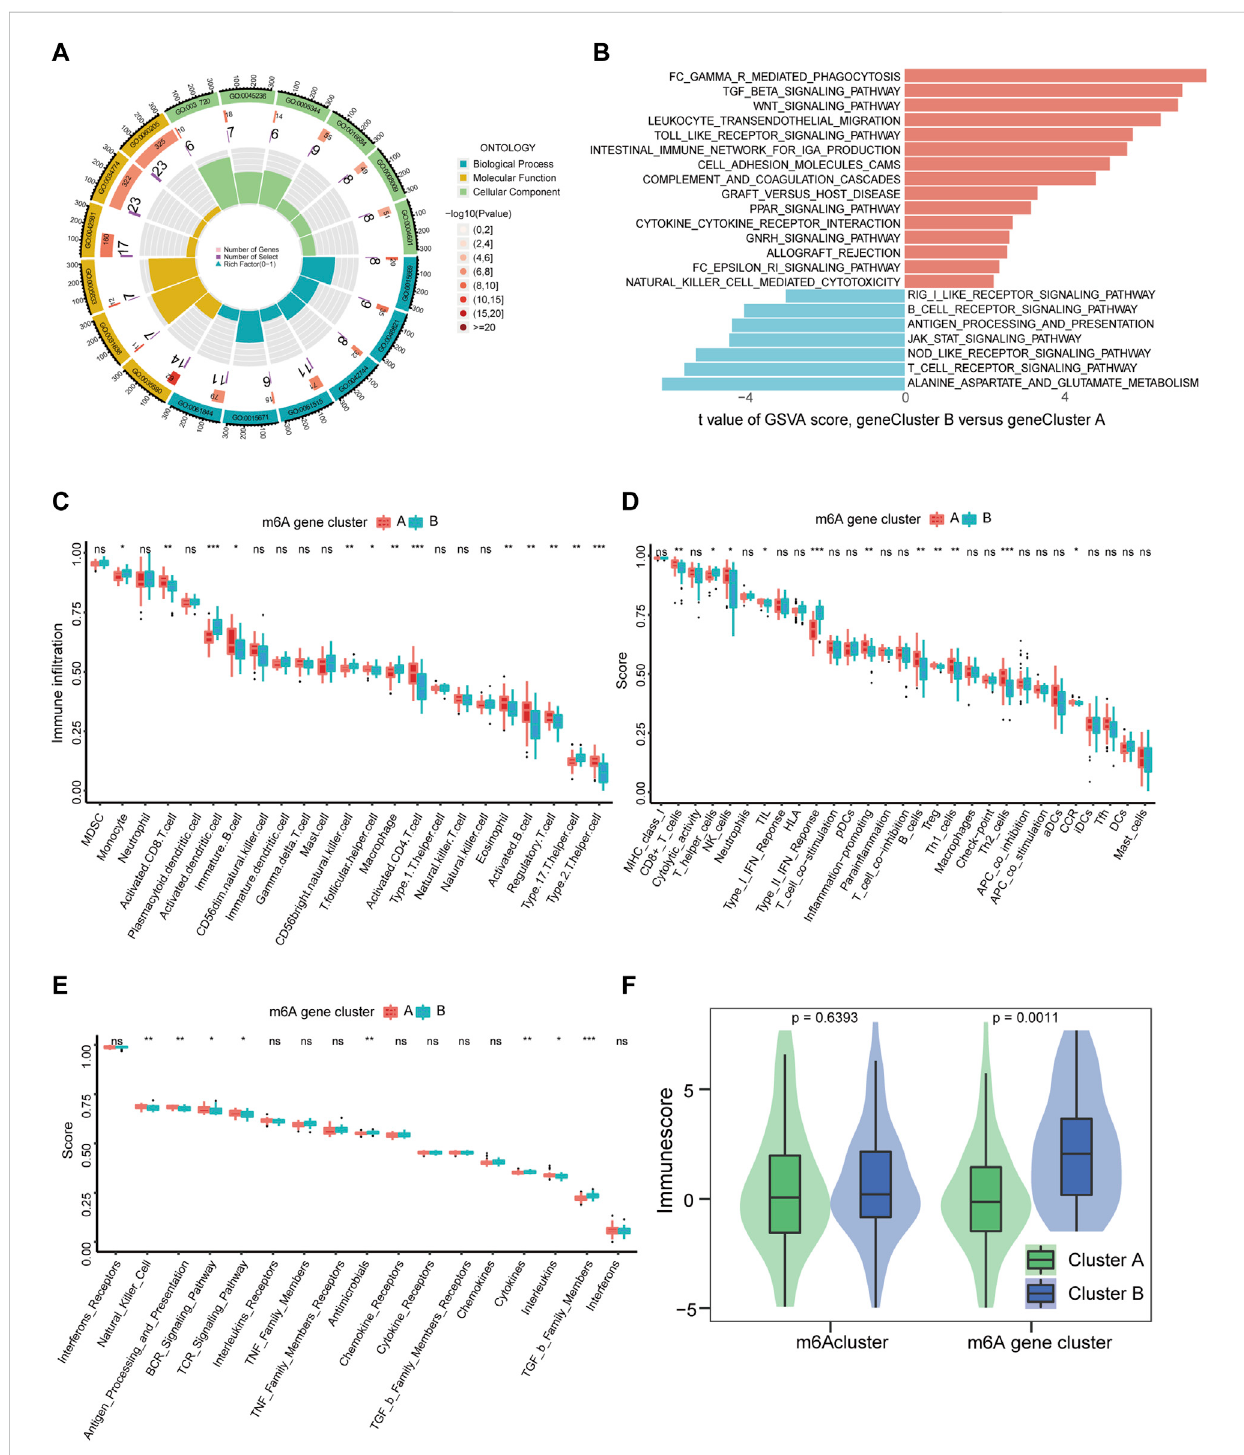
FIGURE 6 Immune signatures of m6A gene modi fi cation patterns. (A) GO functional analysis to explore the potential biological processes of 436 m6A-related DEGs for IS with enrichment circle plot. (B) Differences in KEGG pathway enrichment score. Upregulated pathways are shown in red and downregulated pathways are shown in blue. (C – E) Box plots of the differences in the abundance of immune cells, immune functions, and immune responses in each immune microenvironment, respectively. (F) Differences inimmunecell in fi ltration scores betweenthe two m6Aclusters ( p = 0.6393) and two m6A gene clusters ( p = 0.0011). * p < 0.05, ** p < 0.01, and *** p < 0.001, “ ns ” indicates no signi fi